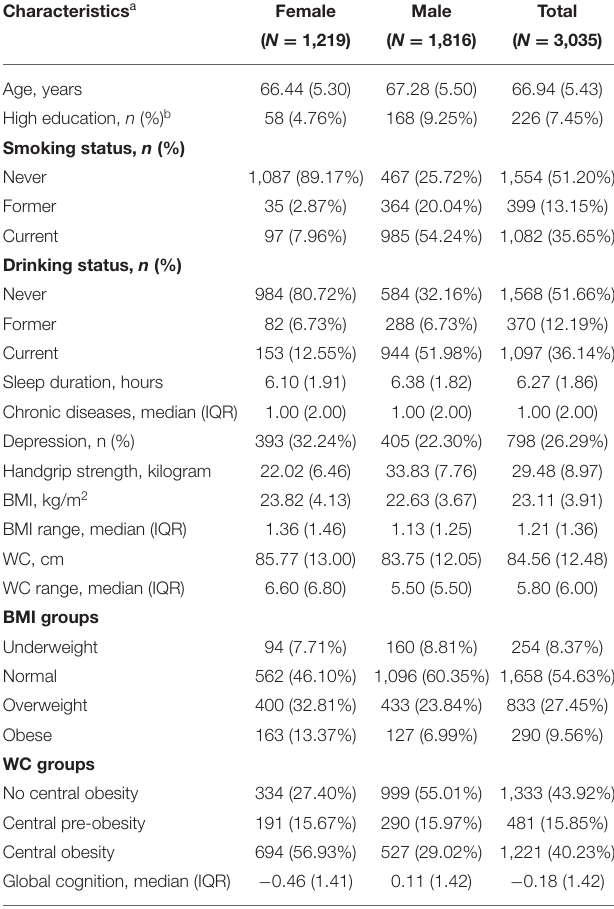
TABLE 1 | Baseline characteristics of